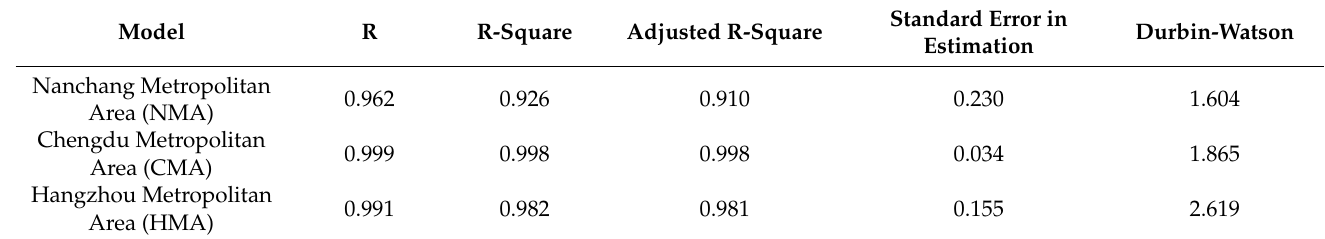
Table 6. Models Summary Table of Three Metropolitan Areas.